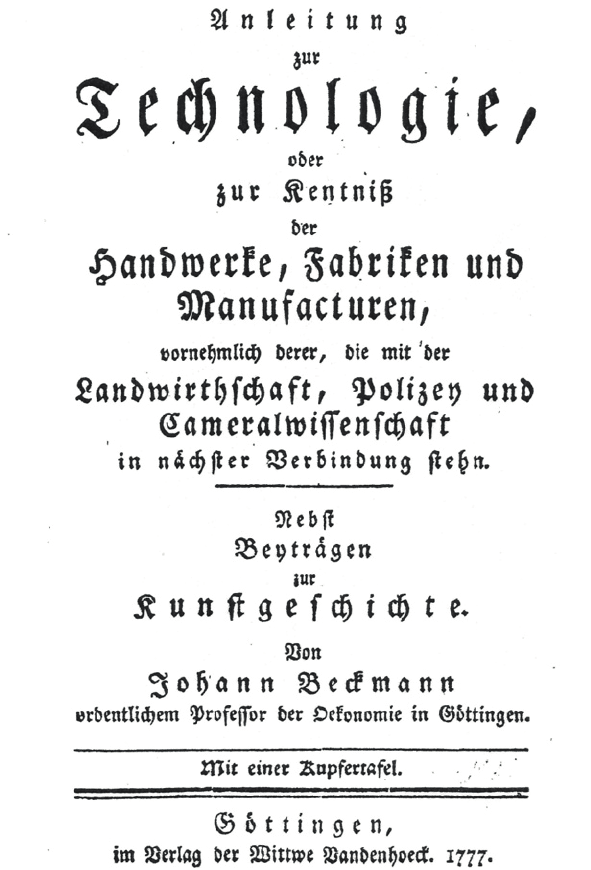
Figure 4. Front page of “Anleitung Zur Technologie”, 1777